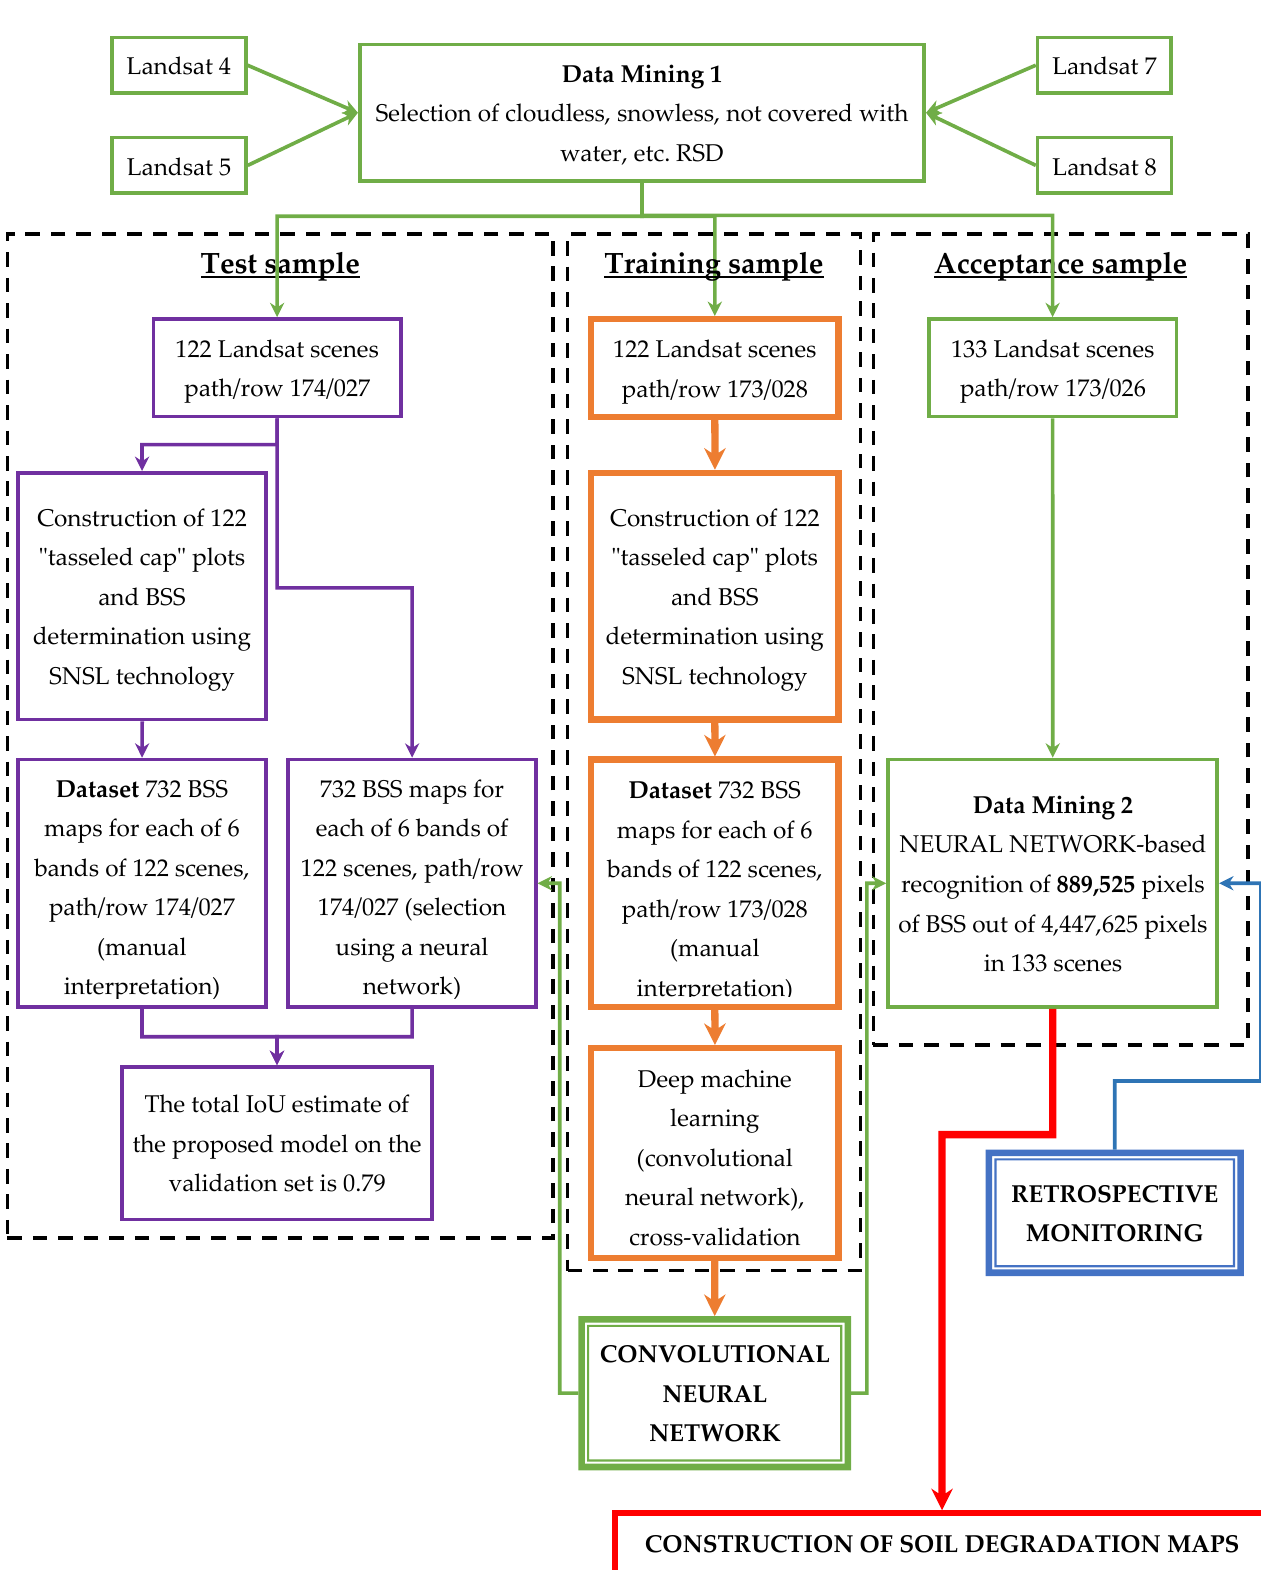
Figure 3. Deep machine learning flowchart.